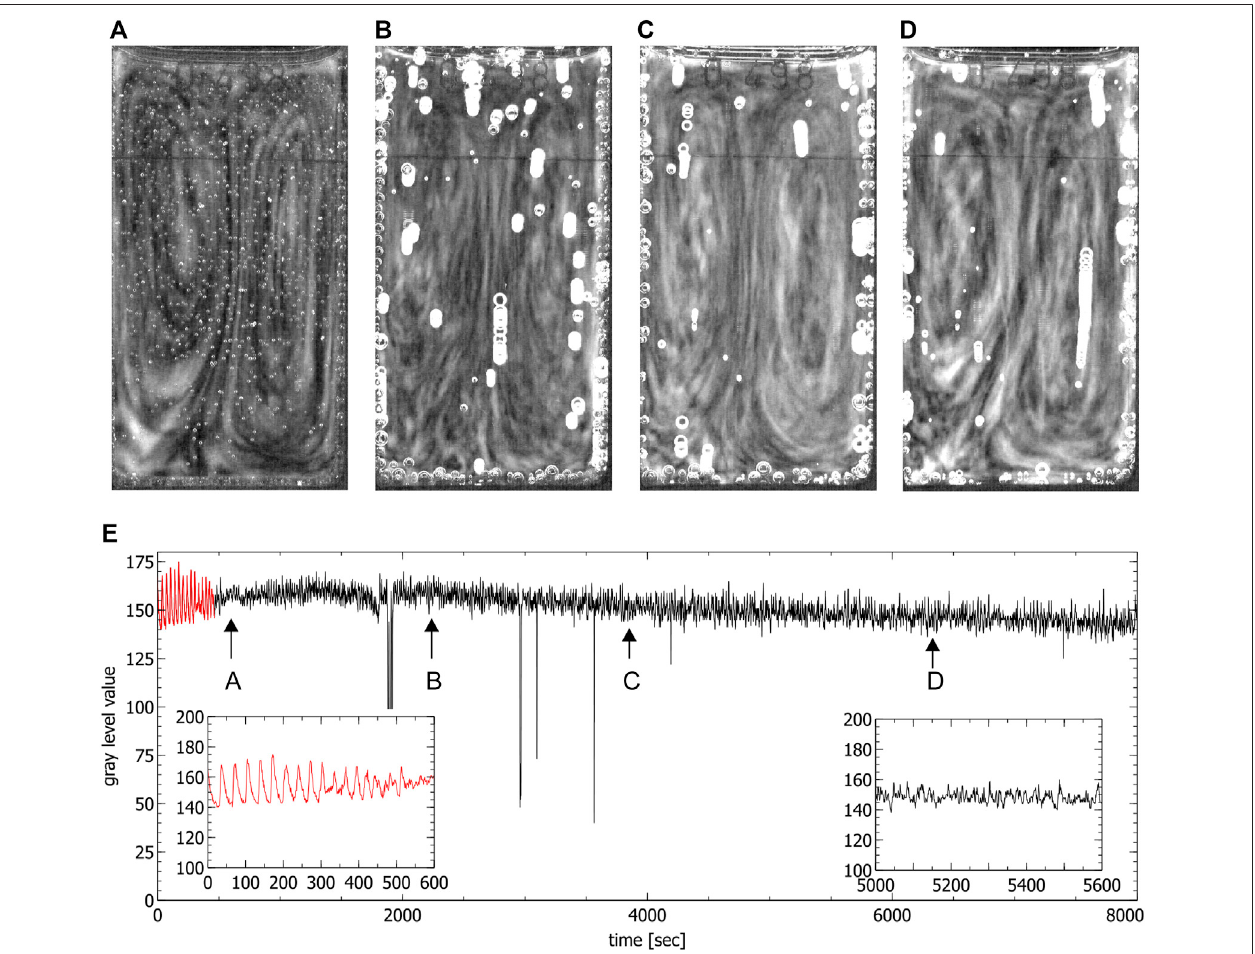
FIGURE 4 | Convection cells in the special cuvette during the chaotic phase. (A – D) show the presence of two convection cells (liquid moves up in the middle and downontheleftandrightside).Imageswereobtainedbyaveragingover60 s, (E) showsthetimeseriesextractedfromthevideodatawheretheredpartcorrespondsto the periodic phase. Arrows indicate the times where the images (A – D) were created (spikes in the time series correspond to the passage of bubbles). Insets show the periodic phase (left) and part of the chaotic phase (right) magni fi ed.